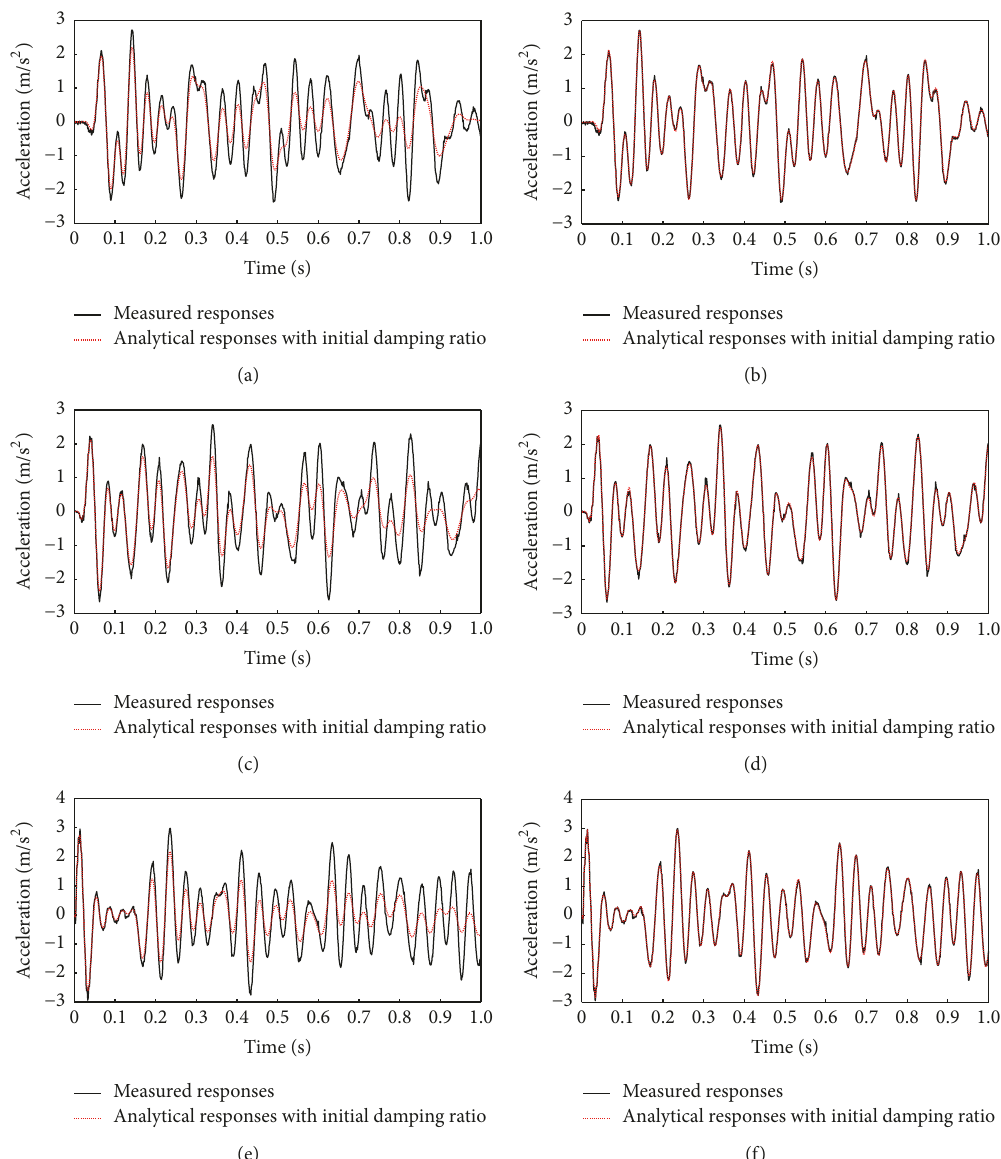
Figure 9: Comparison between the measured responses and the analytical responses. (a) Measured responses and analytical responses with the initial damping ratios at 43x. (b) Measured responses and analytical responses with the identified damping ratios at 43x. (c) Measured responses and analytical responses with the initial damping ratios at 29x. (d) Measured responses and analytical responses with the identified damping ratios at 29x. (e) Measured responses and analytical responses with the initial damping ratios at 15x. (f) Measured responses and analytical responses with the initial damping ratios at 15x.